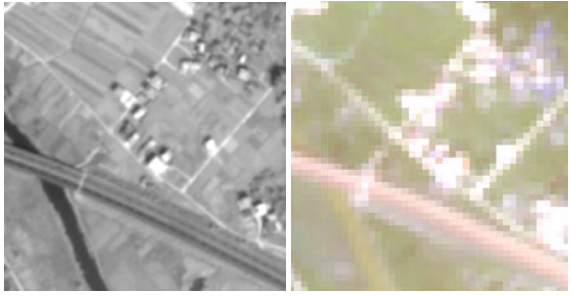
Table 2. Resolutions of ZY3, GF1, and GF2